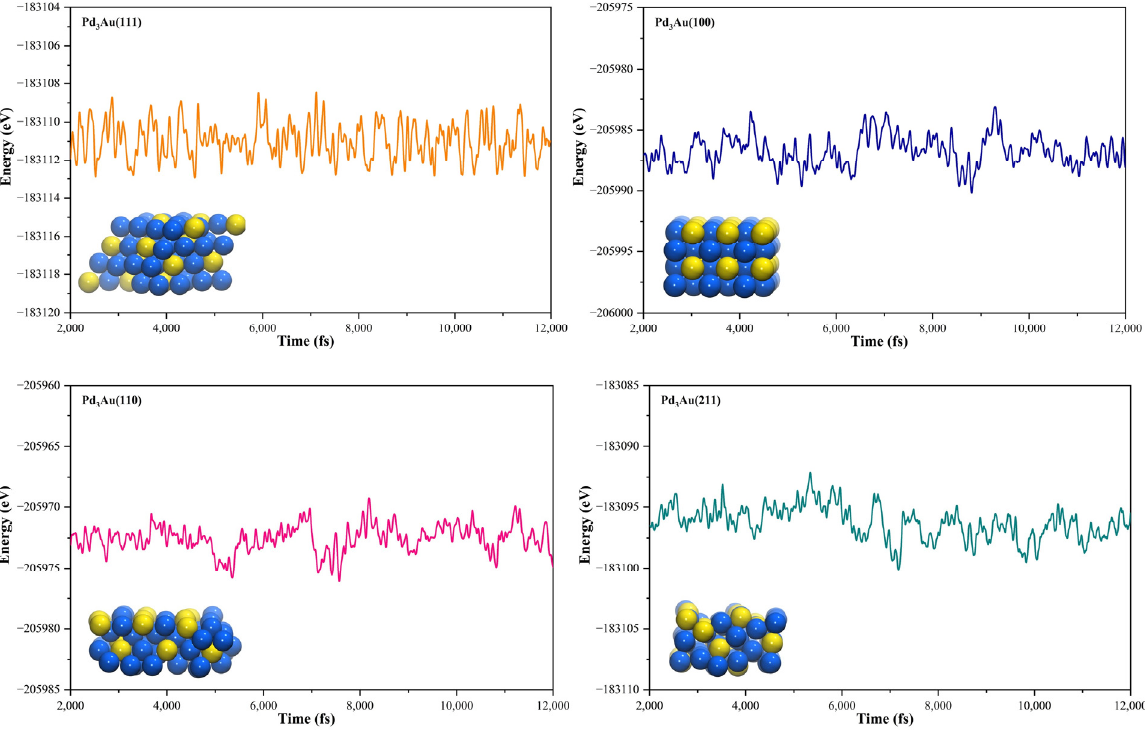
Figure 2. The total energy fluctuations of Pd 3 Au (111), (211), (100), and (110) surfaces, with progress of time (fs) in AIMD simulations at 1000 K. The snapshots of different Pd 3 Au surface geometric structures are displayed (Pd atom is represented by blue sphere and Au atom by yellow sphere).